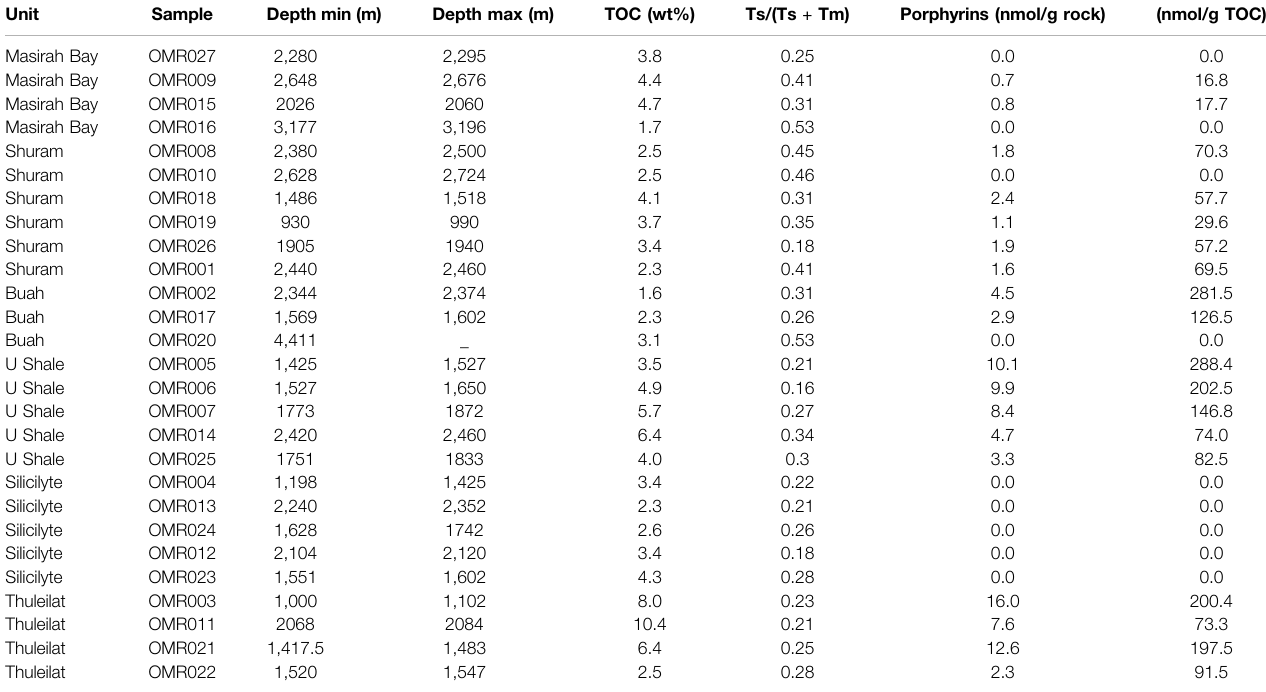
TABLE 1 | Organic carbon, hopanoid-derived thermal maturity (Ts and Tm) and normalized porphyrin concentrations in studied samples. Unit Sample Depth min (m) Depth max (m) TOC (wt%) Ts/(Ts + Tm)